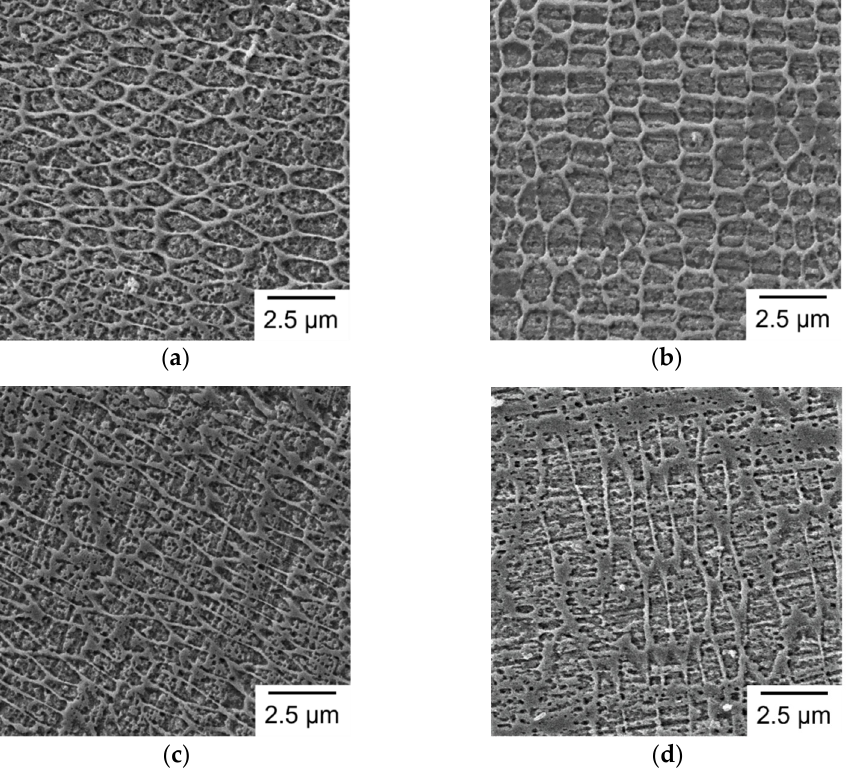
Figure 10. SEM micrographs of sub-grain structure in high-magnification view: ( a ) S1; ( b ) S2; ( c ) S3; ( d ) S4.